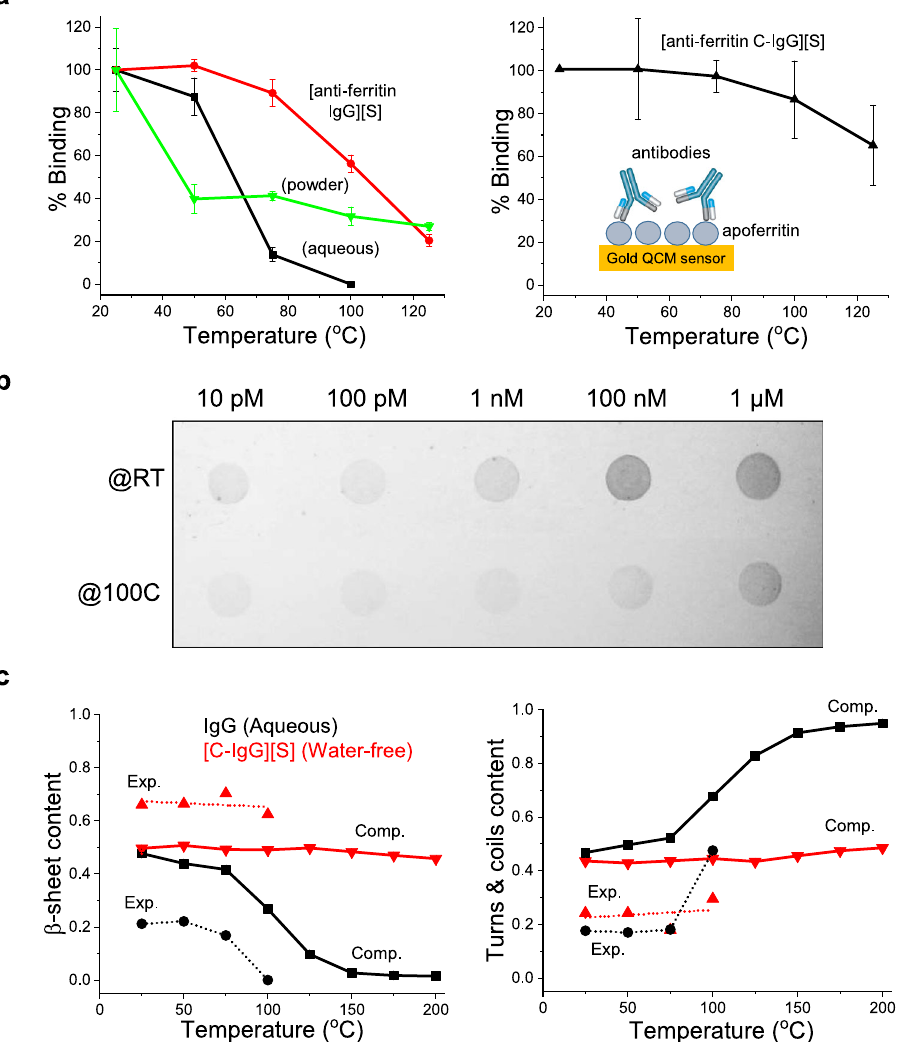
Fig. 2 Thermal stability of antibody liquids. a Quartz Crystal Microbalance (QCM) binding of anti-ferritin in aqueous and powder forms and [anti-ferritin IgG][S] at 1:4 wt ratio after heating (Left plot). Binding of [anti-ferritin C-IgG][S] after repeated heating of same sample (Right plot). Inset shows QCM binding exp. % Binding was determined from conversion of Δ f into an aerial mass (ng/cm 2 ) of adsorbed apoferritin and bound antibody using the Sauerbrey equation and then into a mole ratio. Error bars represent the standard deviation of three separate binding experiments. b Immunoblot binding assay of [anti-ferritin C-IgG][S] at RT and at 100 °C with 10 pM to 1 μ M apoferritin developed colorimetrically with GAR-AP secondary antibodies. c Secondary structure changes of IgG and [C-IgG][S] at equilibria and at different temperatures determined by molecular modeling simulations (labeled comp) and experimentally (labeled exp). Error bars from MD simulations are included in plot and determined from 50 snapshots using VMD. Secondary structure content was also experimentally determined by deconvolution of CD spectra for aqueous IgG and by peak fi tting the Amide I band in FT-IR spectra (re fl ection mode) of water-free [C-IgG][S] to known secondary structure vibrational modes. For IgG, only the turn content is represented